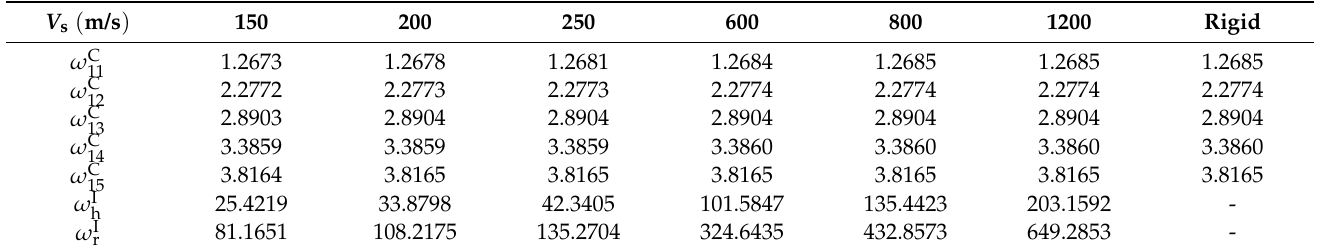
Figure 16. Ratio of the hydrodynamic moment under flexible soil to that under rigid soil for V s . 1